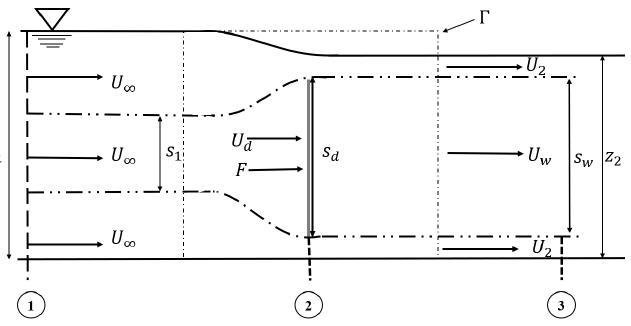
Figure 4. Schematic representation of the flow around an AD in a channel with free surface deformation. The numbers 1–3 represent particular locations (upstream, at the disk,